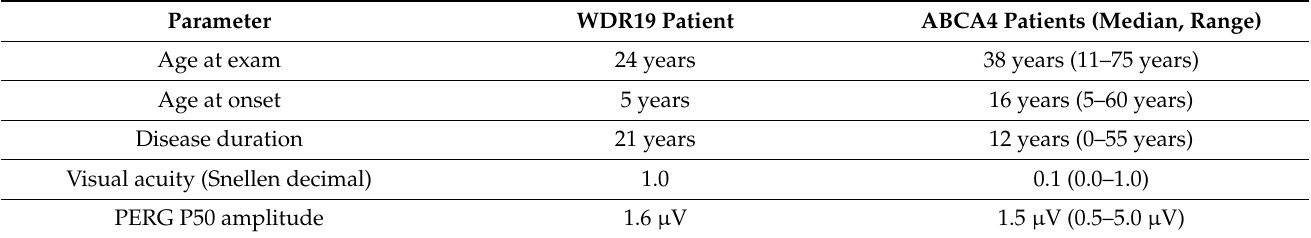
Table 1. Comparison of clinical characteristics of the WDR19 and ABCA4 Stargardt